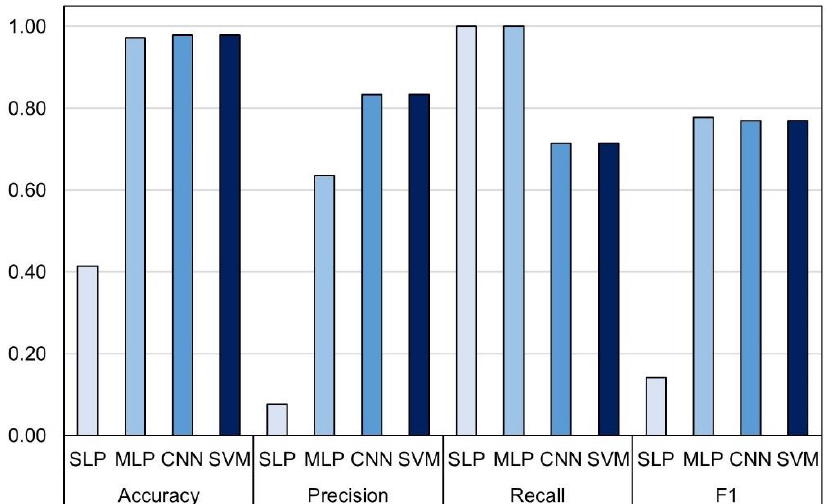
Figure 6. Performance metrics of four tested models: single and multilayer perceptron (SLP and MLP), convolutional neural network (CNN) and support vector machines (SVM) in external dataset.